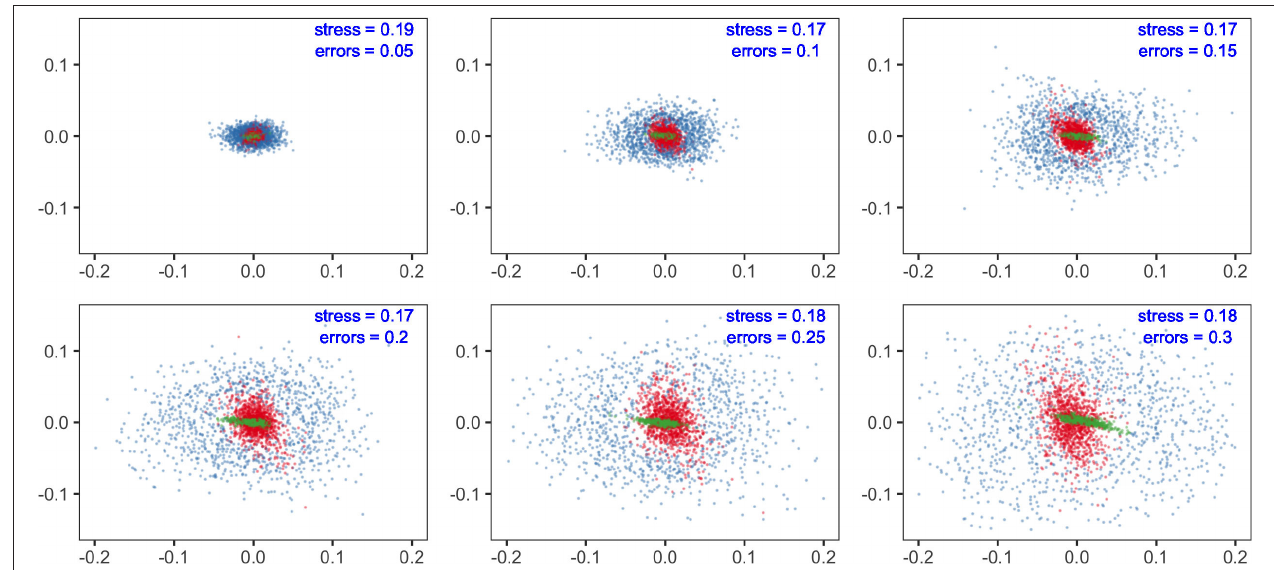
FIGURE 3 | Multidimensional scaling (MDS) analysis of community structure predicted by multispecies size-spectrum model (MSSM). The errors in parameters of concern (fishing effort, E in red; the maximum recruitment, r_max in blue and; the diet selection width, sigma in green) are specified with a range of standard deviations (from 0.05 to 0.3).